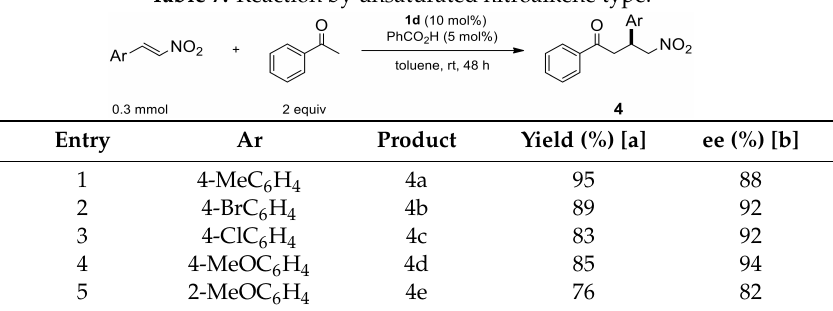
Table 7. Reaction by unsaturated nitroalkene type.